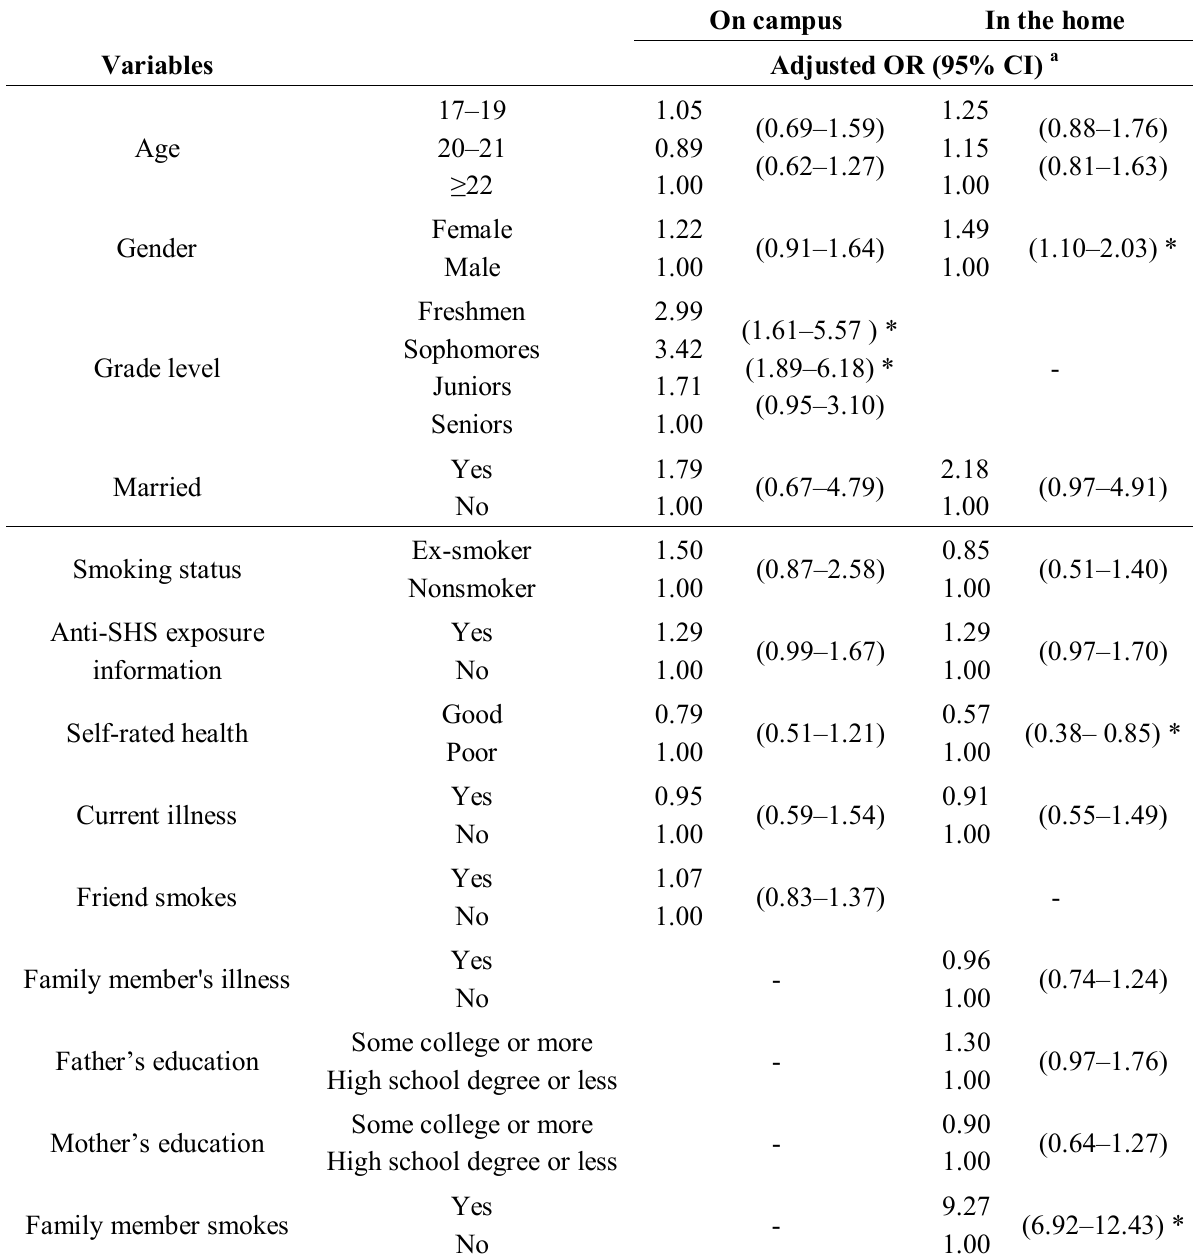
Table 4. Factors associated with secondhand smoke exposure by location (N =